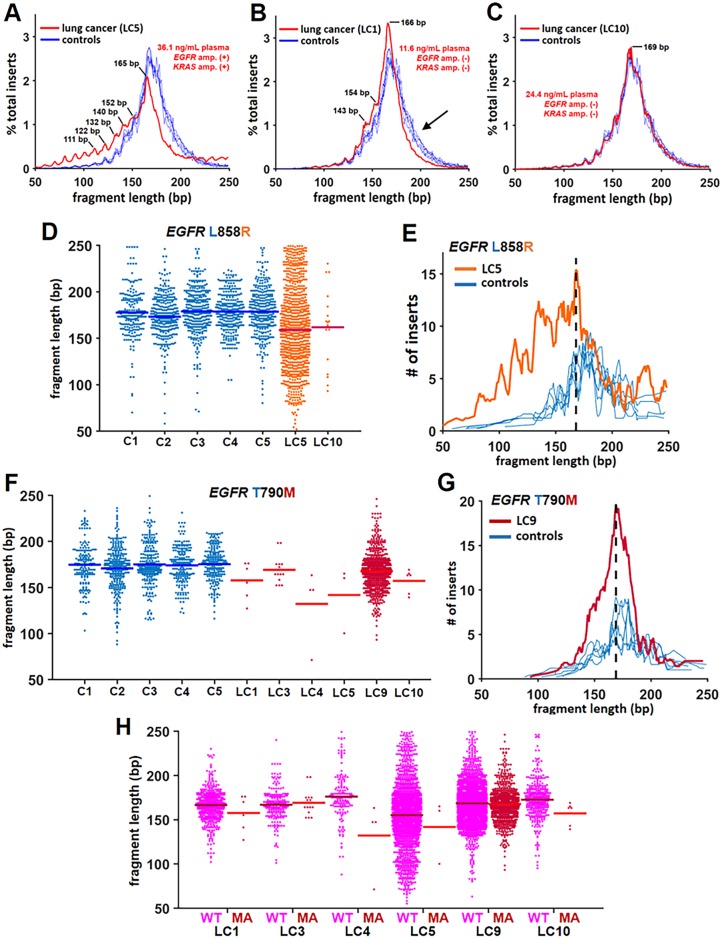
In lung cancer patients, mutant alleles occurred more commonly in shorter fragments of cell-free DNA.In A-C, histograms of overall cell-free DNA fragment length from the entire 16-gene capture panel determined by sequencing compared between five healthy controls (blue lines) and individual tumor patients (red line). Plasma concentration of cell-free DNA and presence (+) /absence (-) of EGFR and KRAS amplifications are also described for each tumor patient. There was a strong left shift (i.e., shorter fragment lengths) and periodicity in LC5 compared to controls (A). In B, there was a subtle shift towards shorter fragment length that was most apparent at longer lengths (black arrow) where fewer inserts from the tumor patient (LC1) were present compared to the healthy controls. In C, no difference between the tumor patient (LC10) and the healthy controls was observed. In D, the length of fragments containing the WT or mutant EGFR allele is shown for healthy controls (blue dots) and tumor patients with the mutant L858R allele (orange dots). The solid bars indicate the mean fragment length for each sample. In E, a histogram of the fragment lengths of the mutant L858R allele from LC5 (orange line) vs. the WT allele in healthy controls (blue lines) demonstrates a higher prevalence of mutant allele at shorter fragment lengths. The black dashed-line identifies the fragment length that corresponds to the most inserts in the tumor patient. Note that the mutant allele more commonly occurs at shorter fragment lengths while the WT allele in healthy controls occurs more commonly at longer fragment lengths. In F, the fragment length associated with EGFR for the WT allele in the healthy controls (blue dots) and tumor patients with the mutant T790M allele (red dots) is displayed. The solid bars correspond to mean fragment length for each sample. In G, a histogram of the fragment length of the mutant allele (L858R) from LC9 (red line) vs. the WT allele in healthy controls (blue lines) is shown. The black dashed-line identifies the fragment length that corresponds to the most inserts in the tumor patient. Note that the WT allele in healthy controls more commonly occurs at longer fragment lengths. In H, the EGFR fragment length associated with the WT allele (pink dots) and the mutant T790M allele (MA; red dots) in each of the tumor patients are depicted. The mutant allele more commonly occurred at a shorter fragment length compared to the length of the WT allele within the same patient.